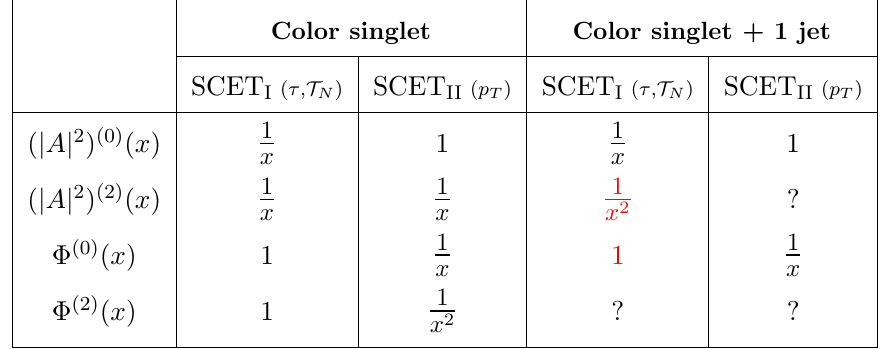
Table 1 . Behavior of the most singular terms for matrix element squared contributions ( j A j 2 ) ( k ) and phase space (cid:8) ( k ) , at both leading power k = 0 and subleading power k = 2, for a single emission when the energy fraction of the emission x ! 0. The contribution to the cross section involves products of these terms: d (cid:27) ( i + j ) (cid:24) A ( i ) (cid:2) (cid:8) ( j ) , see eq. (4.10). In red we highlight the terms analyzed in this paper. We take the explicit results for A (2) and (cid:8) (2) for fully di(cid:11)erential color singlet production in SCET I from [38], while those for SCET II are taken from [77]. Entries with \?" have not yet appeared in the